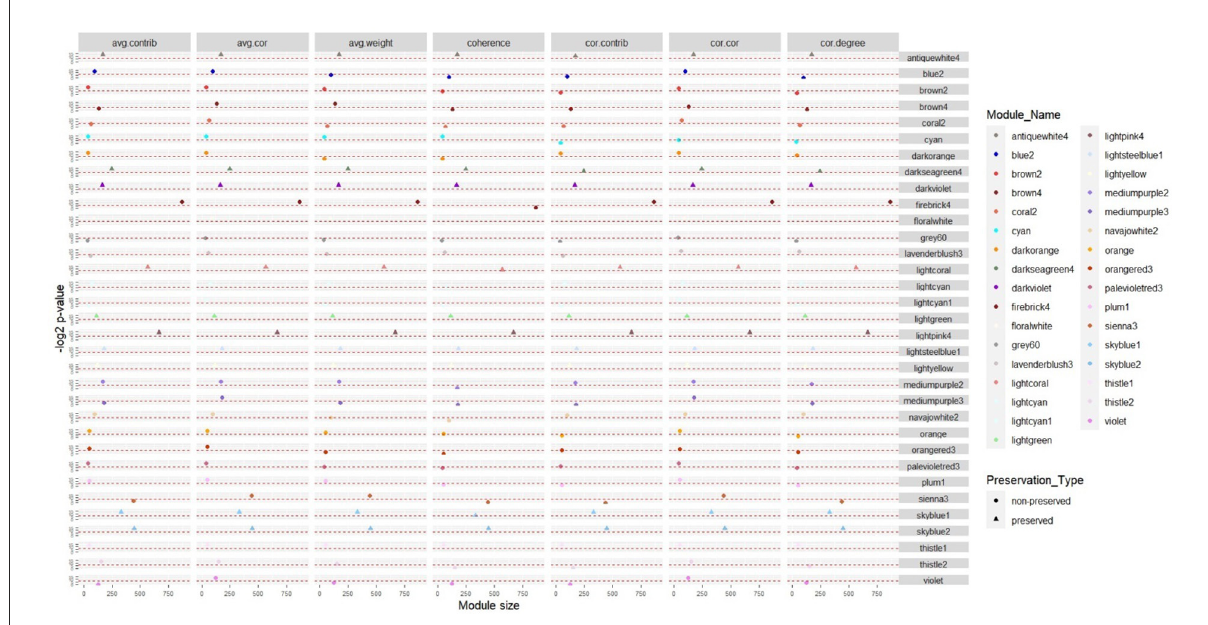
FIGURE2 Consensus modules with the same preservation status in the two datasets based on seven module preservation statistics. The modules with –log2 p -value in all preservation statistics > 6.64 ( p ≤ 0.01) were preserved, otherwise they were non-preserved.